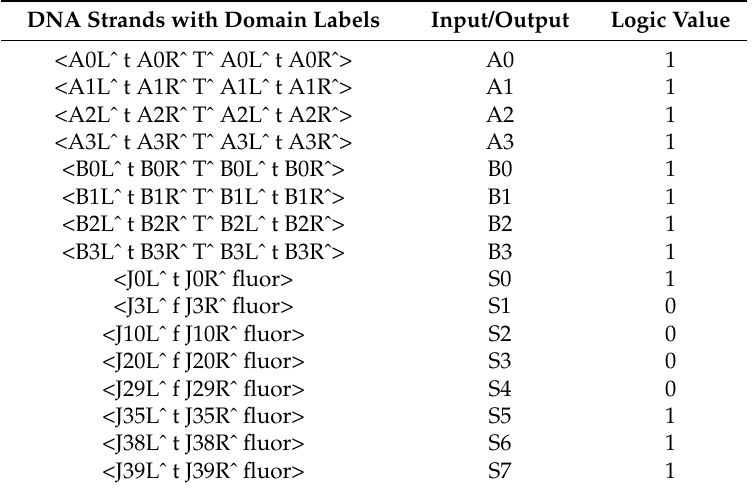
Table 2. Logic values of DNA signal strands (1111 × 1111 = 11100001). DNA Strands with Domain